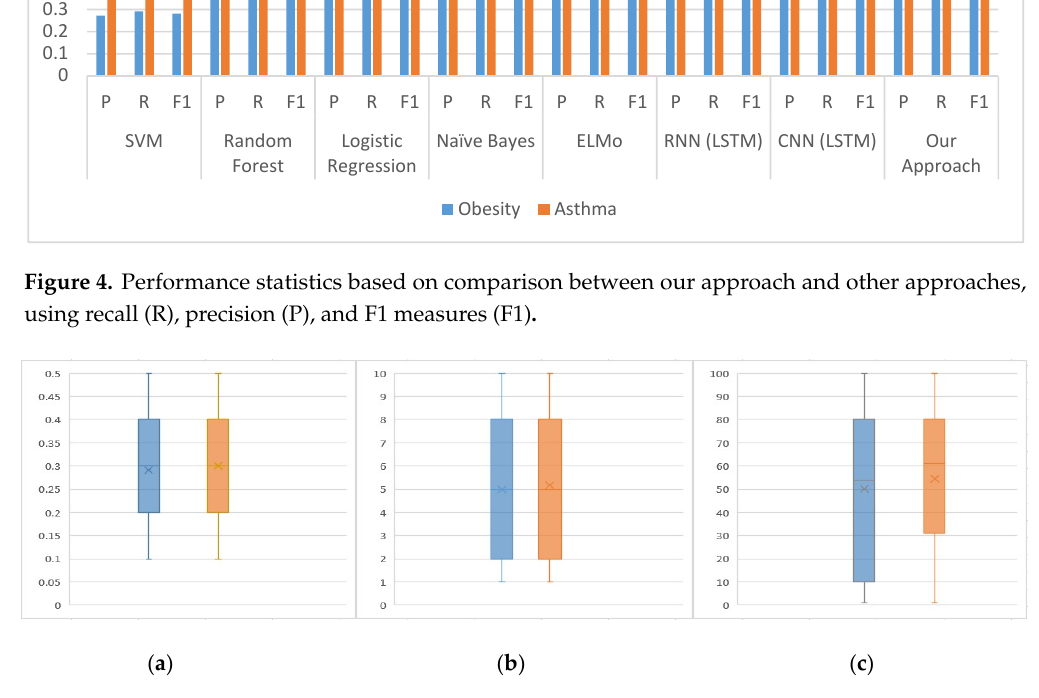
Figure 5. The optimal parameters values optimization process, ( a ) values for λ parameter for asthma (blue color), and obesity (orange color), ( b ) values for C parameter for asthma and obesity, ( c ) values for Nelm parameter for asthma and obesity.